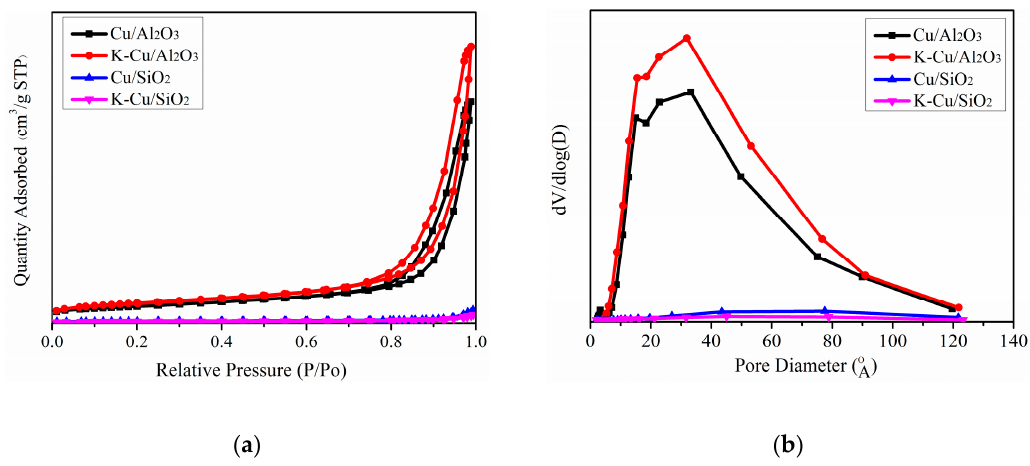
Figure 2. ( a ) Nitrogen adsorption-desorption isotherms and ( b ) pore size distribution of Cu/Al 2 O 3 , K-Cu/Al 2 O 3 and Cu/SiO 2 , K-Cu/SiO 2 catalysts .